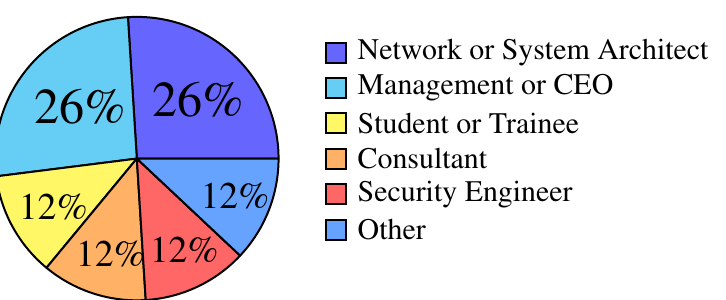
Figure A4. Job roles of participants (n =